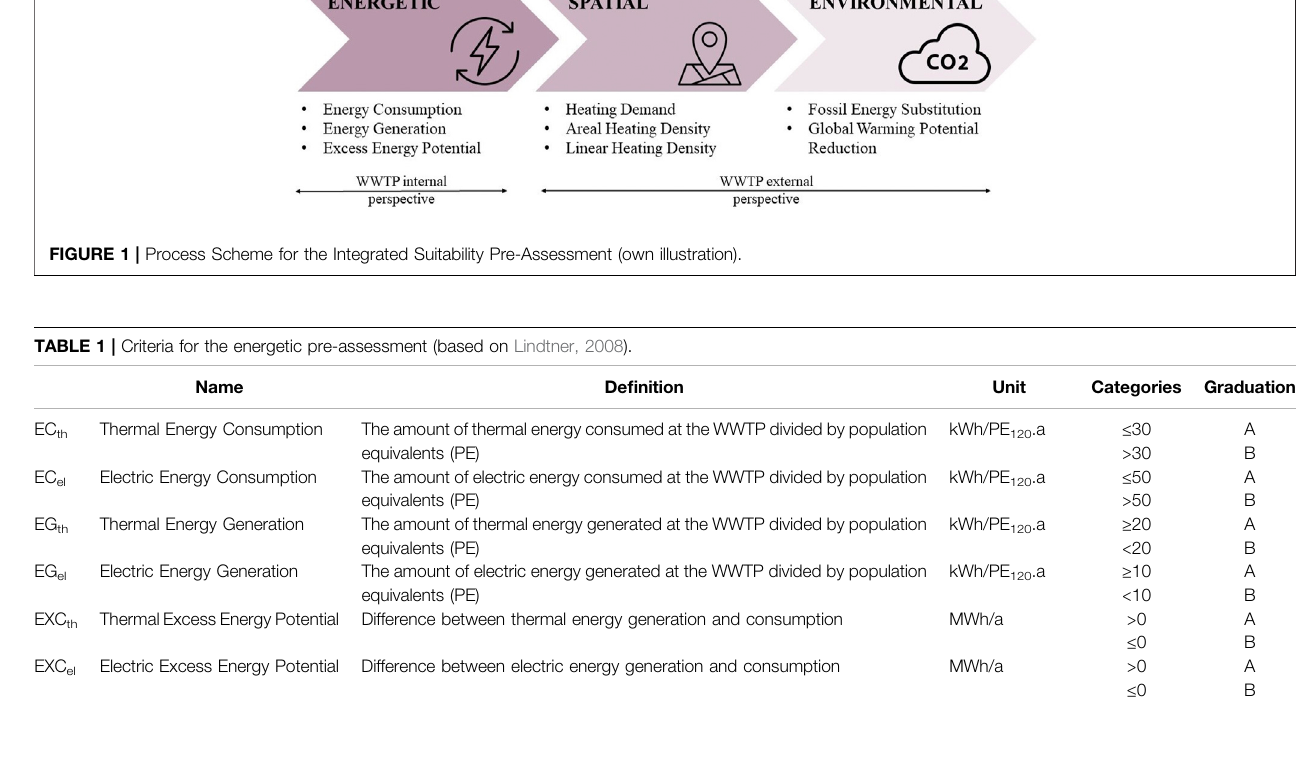
Table 1 . The ef fi ciency is assessed according to Austrian national benchmarks for (activated sludge) WWTPs according to Lindtner (2008). As these fi gures are in fl uenced by local conditions, it is recommended to use country or region-speci fi c benchmarks if available.